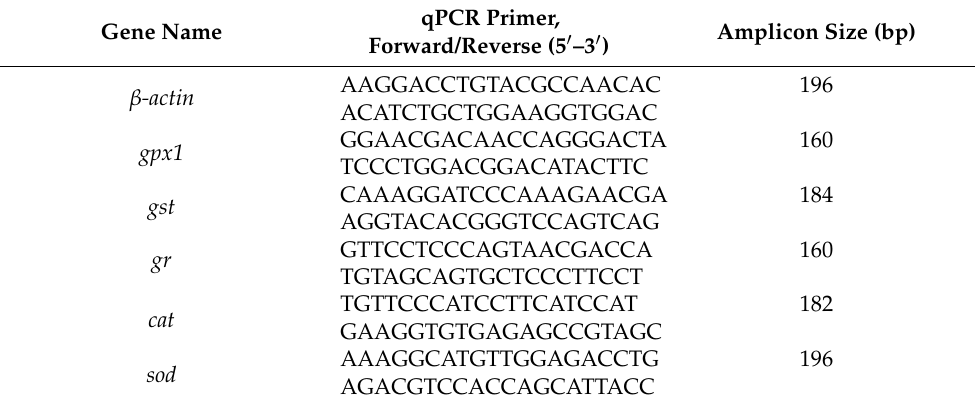
Table 1. Tilapia primers used for qRT-PCR in the current